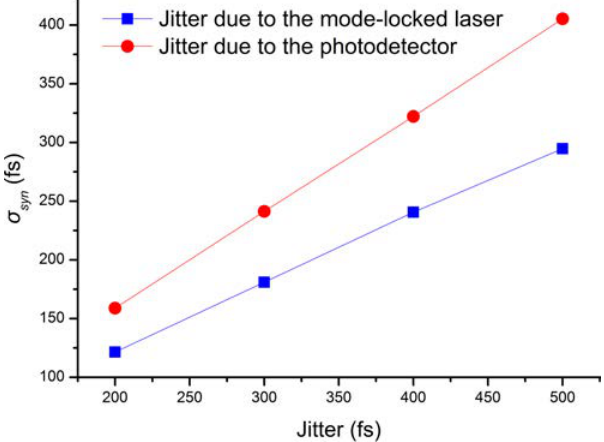
Fig. 3. Relative timing jitter as a function of the timing jitter introduced either by photodetection (red circles), or by the mode-locked laser (blue squares). Each data point is the aver- age of ten successive